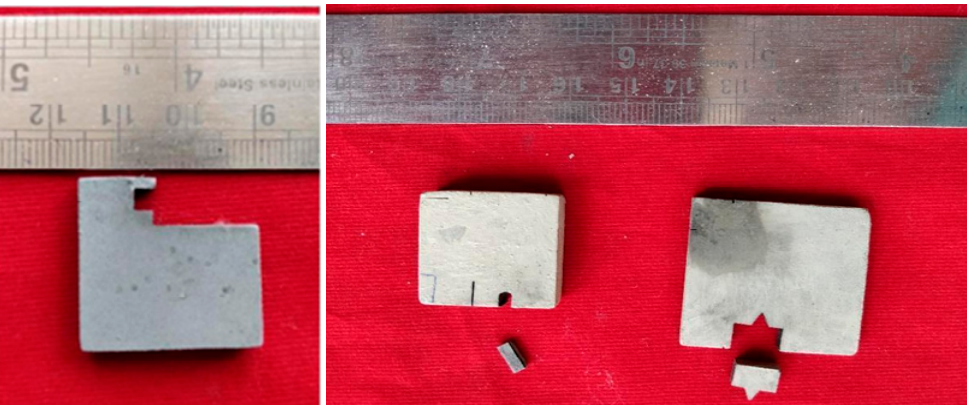
Figure 8. Processed X-ray diffraction of the metal matrix composite structure Al-SiC-TiC.